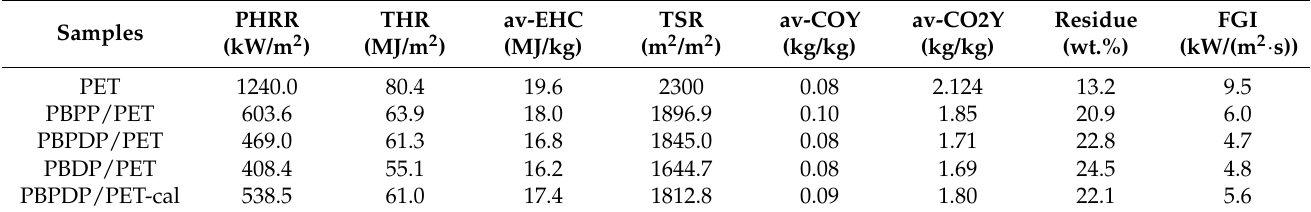
Table 2. The detail information of the cone test.